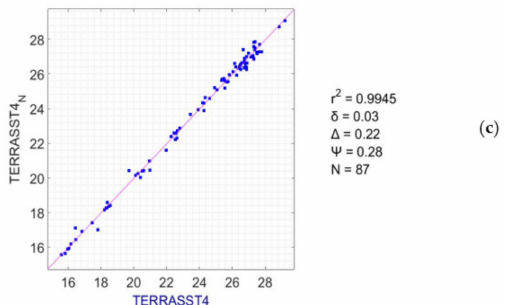
Figure 11. ( a ) TERRASST4 (in situ logger’s cell) data compared with TERRASST4_N (respective northern adjacent cell) data from the same satellite’s swath. All data have quality flags of 0, 1, and 2. ( b ) Di ff erence between the TERRASST4 minus the TERRASST4_N dataset. ( c ) Correlation plot between the TERRASST4 and the TERRASST4_N dataset (refer to Section 2.4 for